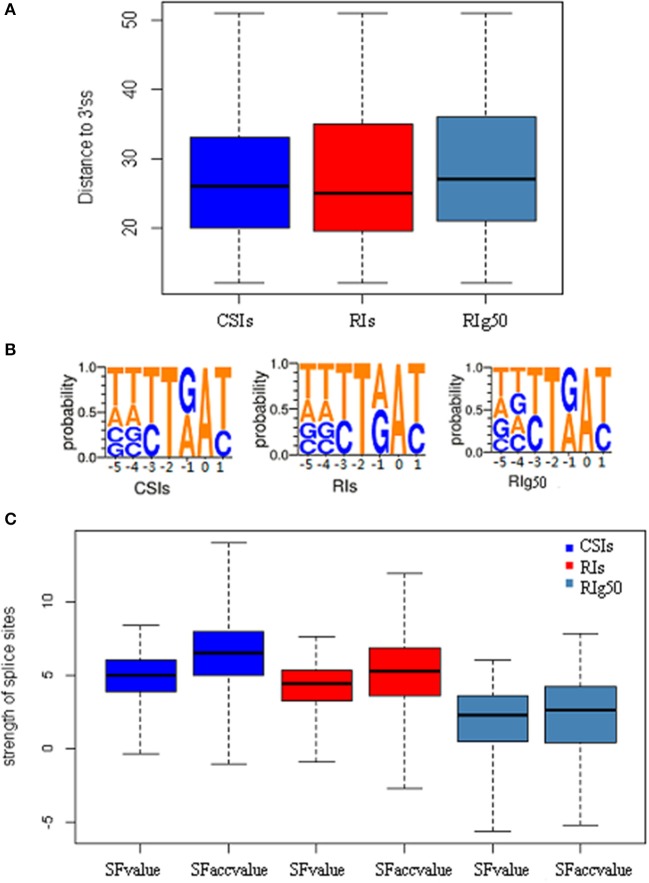
The distribution features of conservative sequence motifs at the branch point. Here all negative samples (CSIs, blue color), positive samples(RIs, red color) and positive samples with more-than-1.0 expressional retention odds of RI-set-stage-expressed (RIg50, navy blue color) are chosen for the comparisons. (A) The length distribution of branch point sequence motifs from the acceptor site (3′ss) to the branch point A. (B) The weblogo of the branch point sequence motifs. The vertical scale indicates the nucleotide occurrence probabilities of A, T, C, and G. All branch point sequence motifs is strictly aligned with the branch point (A, 0 point). (C) The features of splicesites. SFvalue, SFaccvalue indicate the strength of the splice sites, and IDdonv, IDacceptv represent the similarity between two flanking sequences of corresponding splice sites.